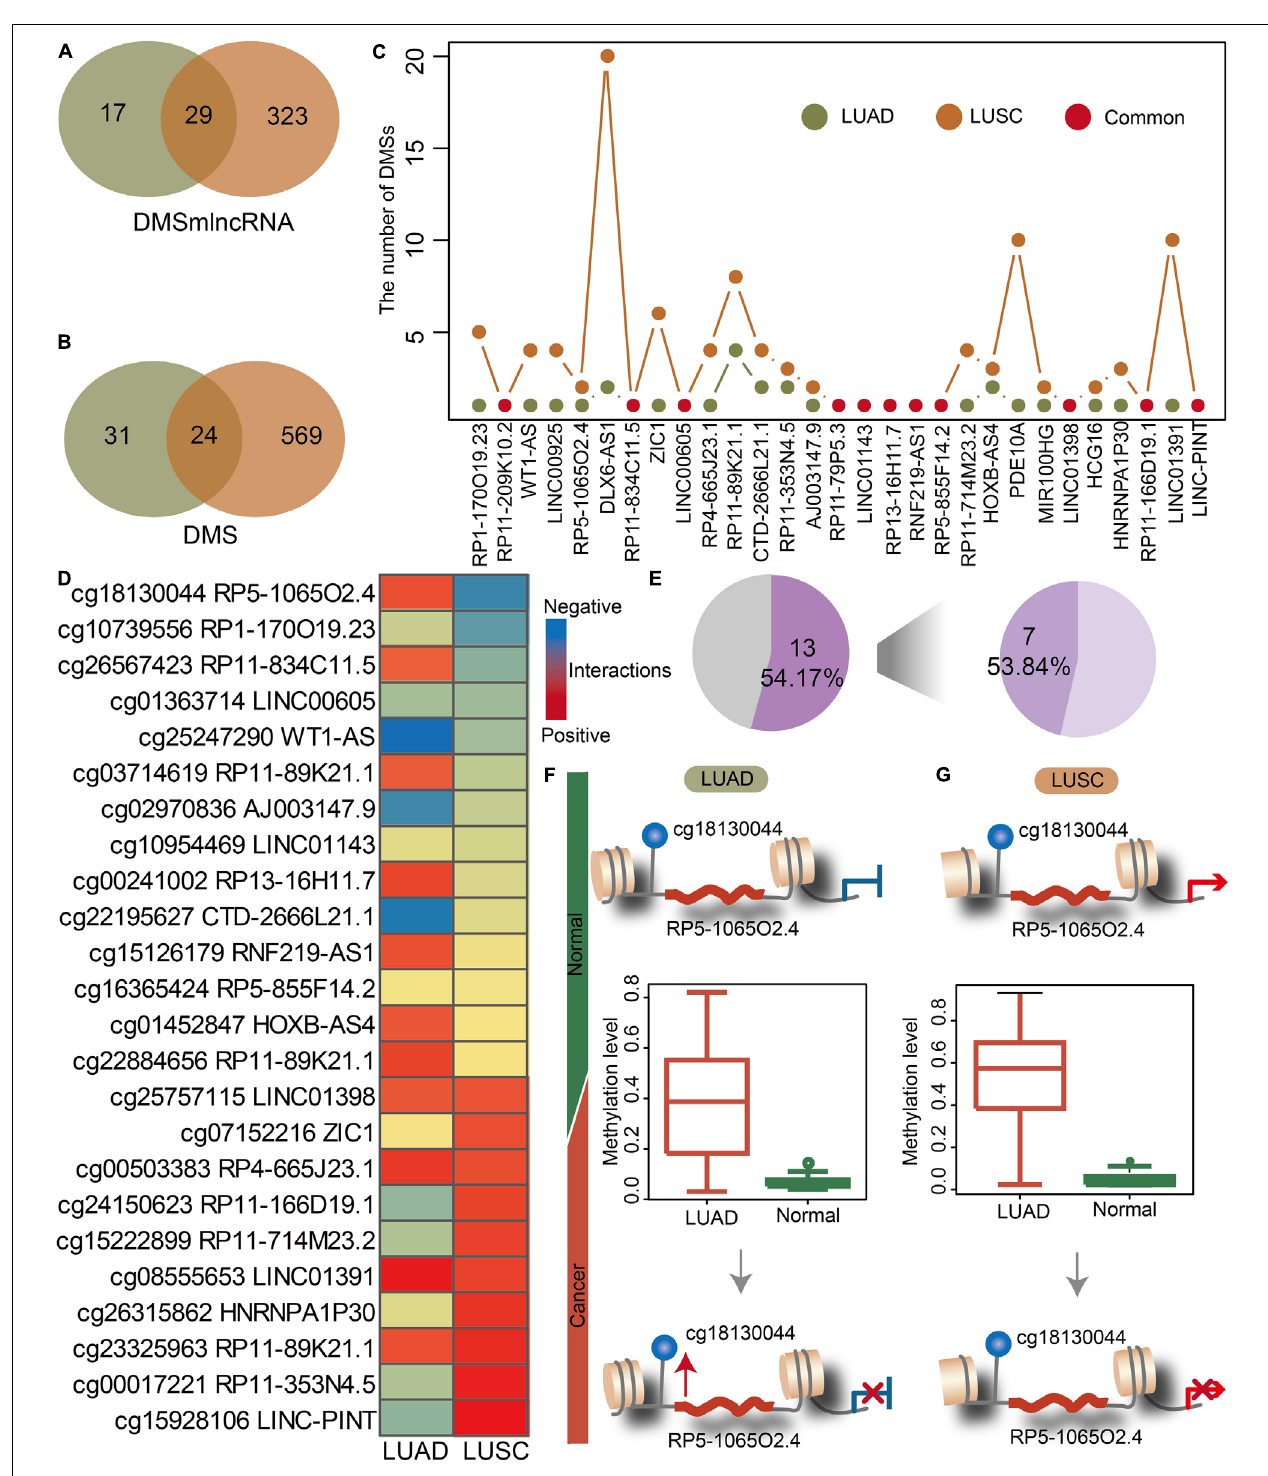
FIGURE 3 | The common and specific lnc-eQTMs between LUAD and LUSC indicate differences in the mechanisms underlying different lung cancer subtypes. (A) Venn plot showing common DMSmlncRNAs in lnc-eQTMs between LUAD (green) and LUSC (orange). (B) Venn plot showing common DMSs in lnc-eQTMs between LUAD (green) and LUSC (orange). (C) Line plot showing the number of DMSs for common DMSmlncRNAs in LUAD and LUSC. (D) Heatmap showing the PCCs of each common lnc-eQTM in LUAD and LUSC. Red and blue represent positive and negative interactions, respectively. (E) Pie chart showing the percentage of opposite PCCs between LUAD and LUSC. (F) The possible mechanism of lnc-eQTMs in LUAD. (G) The possible mechanism of lnc-eQTMs in LUSC.